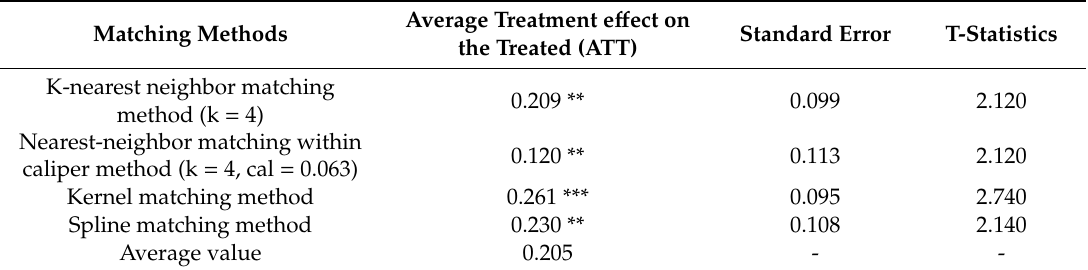
Table 4. Impact of waste sorting on China rural household green consumption. Matching Methods